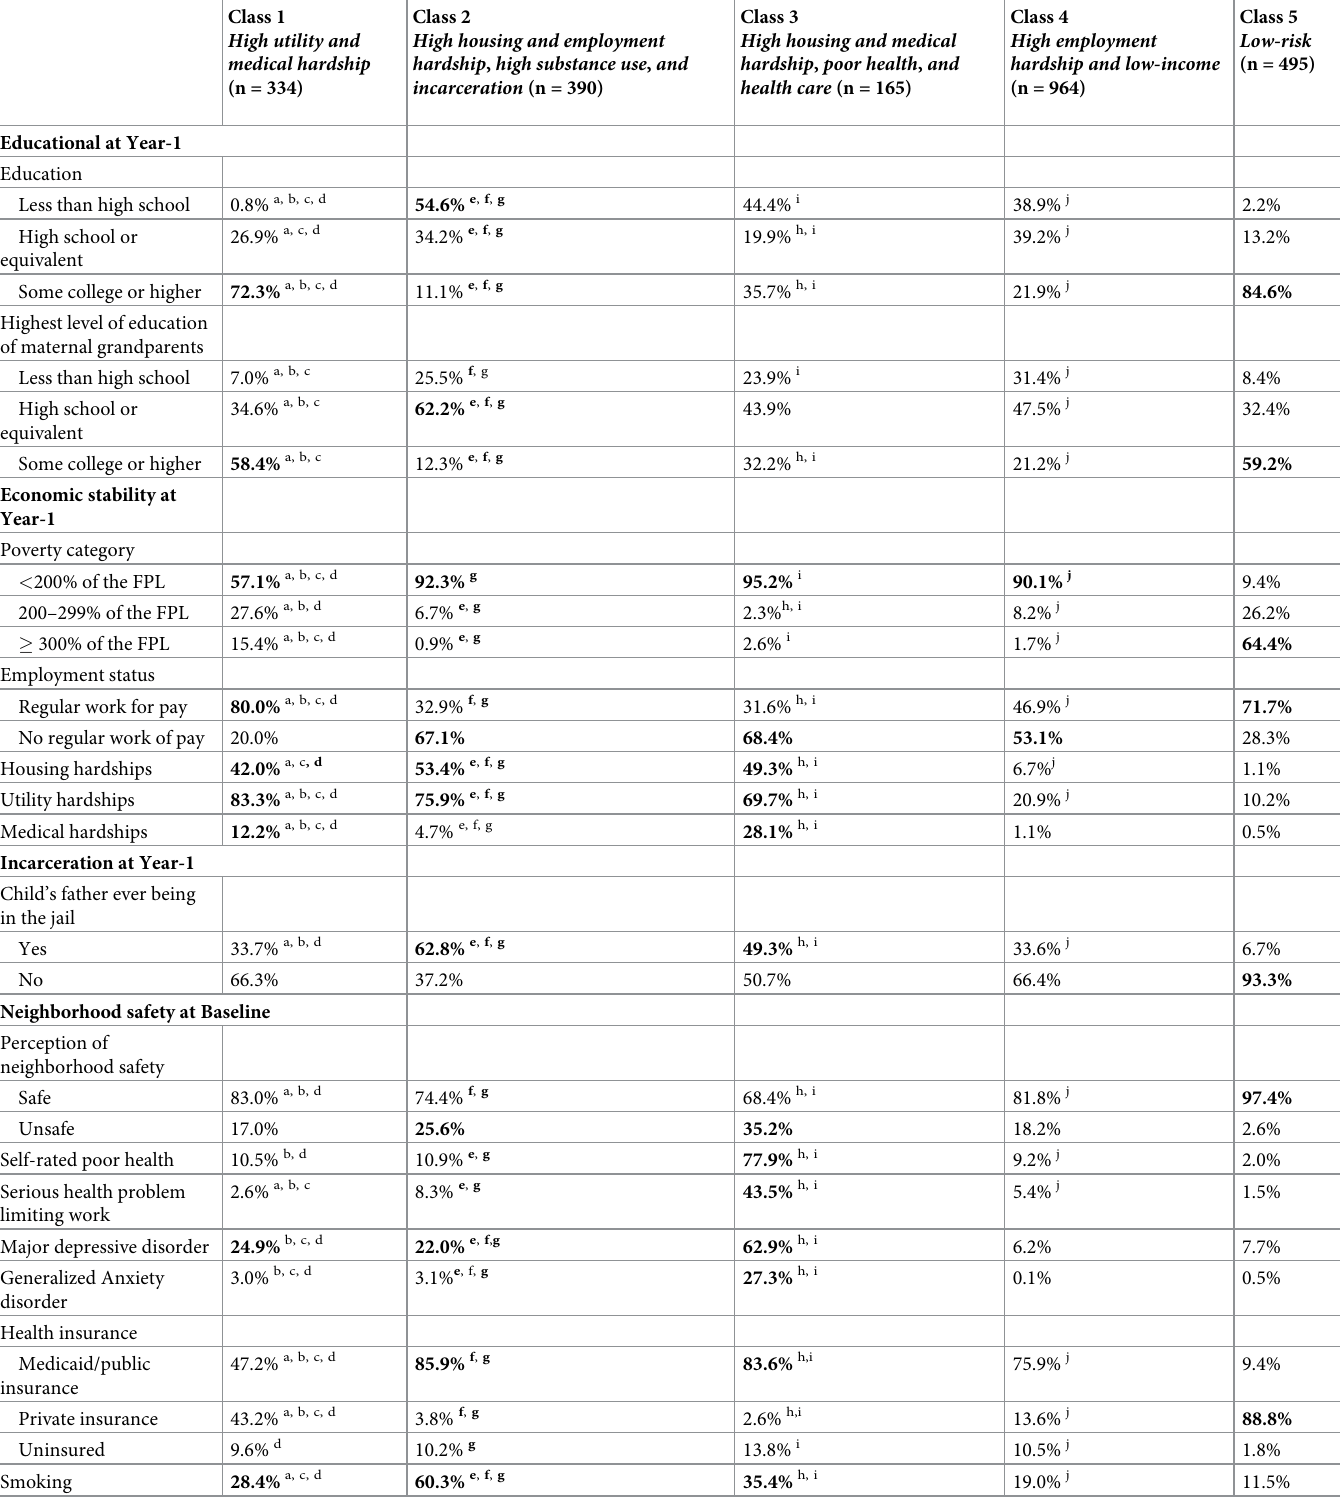
Table 3. Maternal risk profiles/composition of the identified five latent classes reported as mean (SD) or % (n =